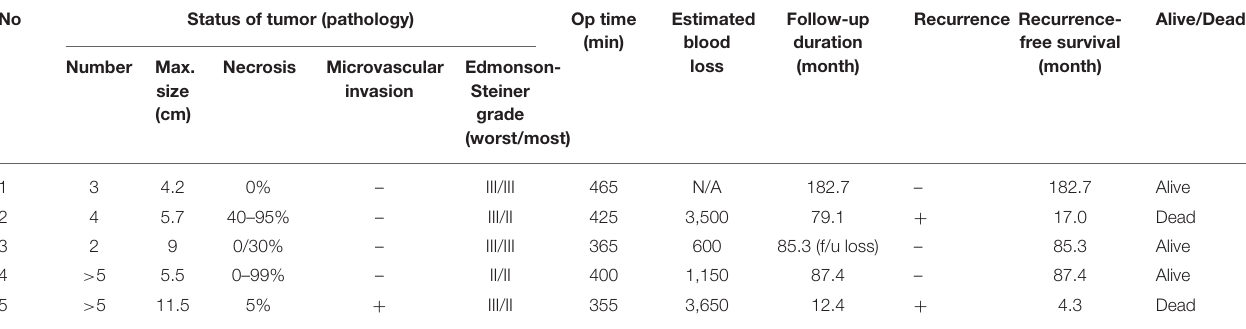
Estimated Follow-up Recurrence Recurrence- Alive/Dead (min) blood duration free survival loss (month) (month)